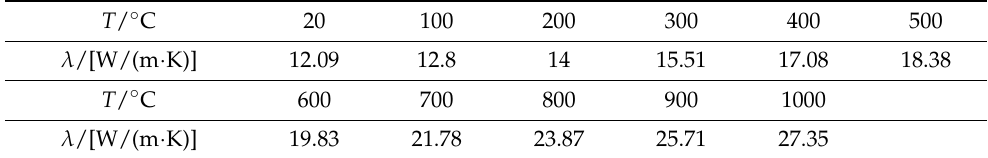
Table A4. Thermal conductivity ( λ ) of rotational solid material.